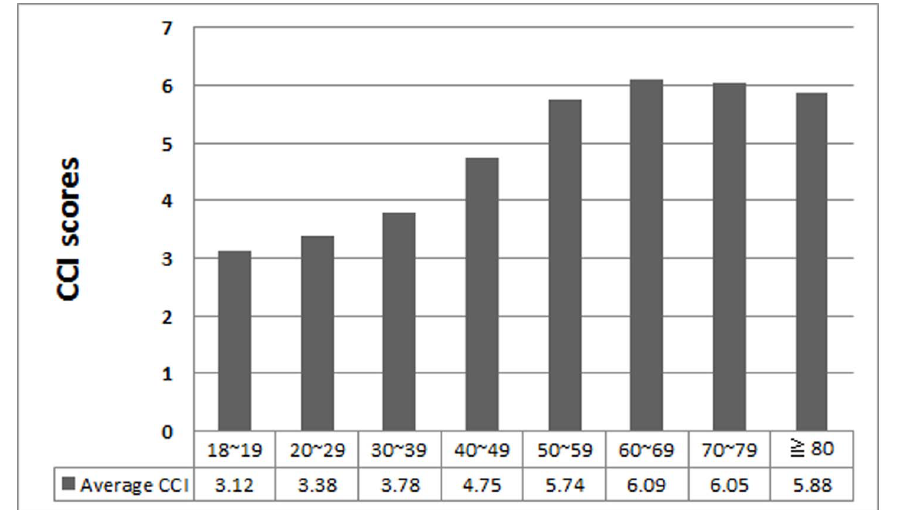
Figure 1. Average comorbidity scores by age group.